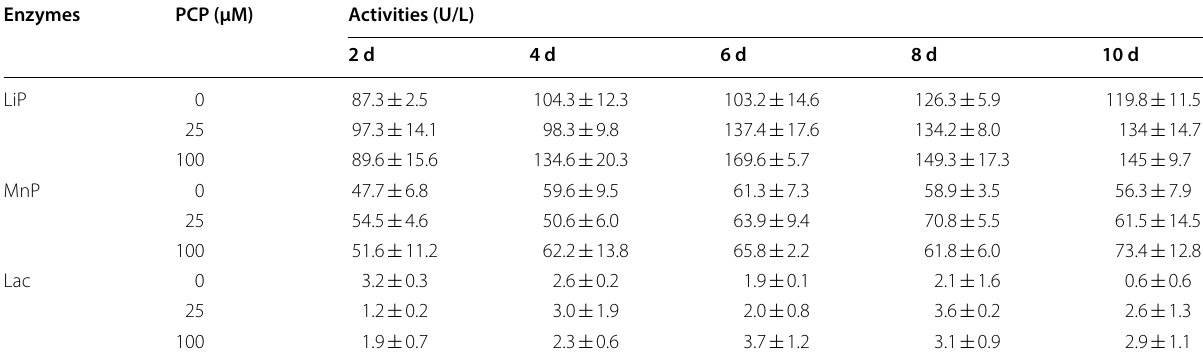
Values are mean